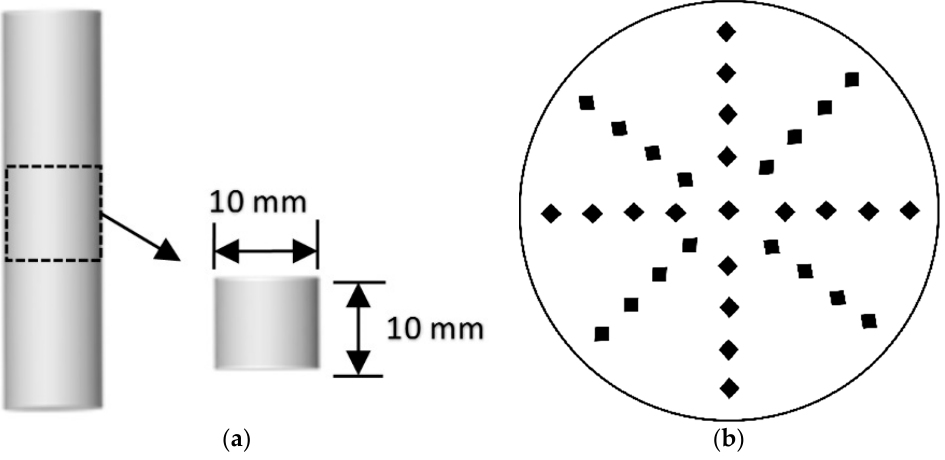
Figure 2 . ( a ) The preparation of the sample used for microhardness; ( b ) Cross-sectional schematics of the sample used in the Vickers microhardness